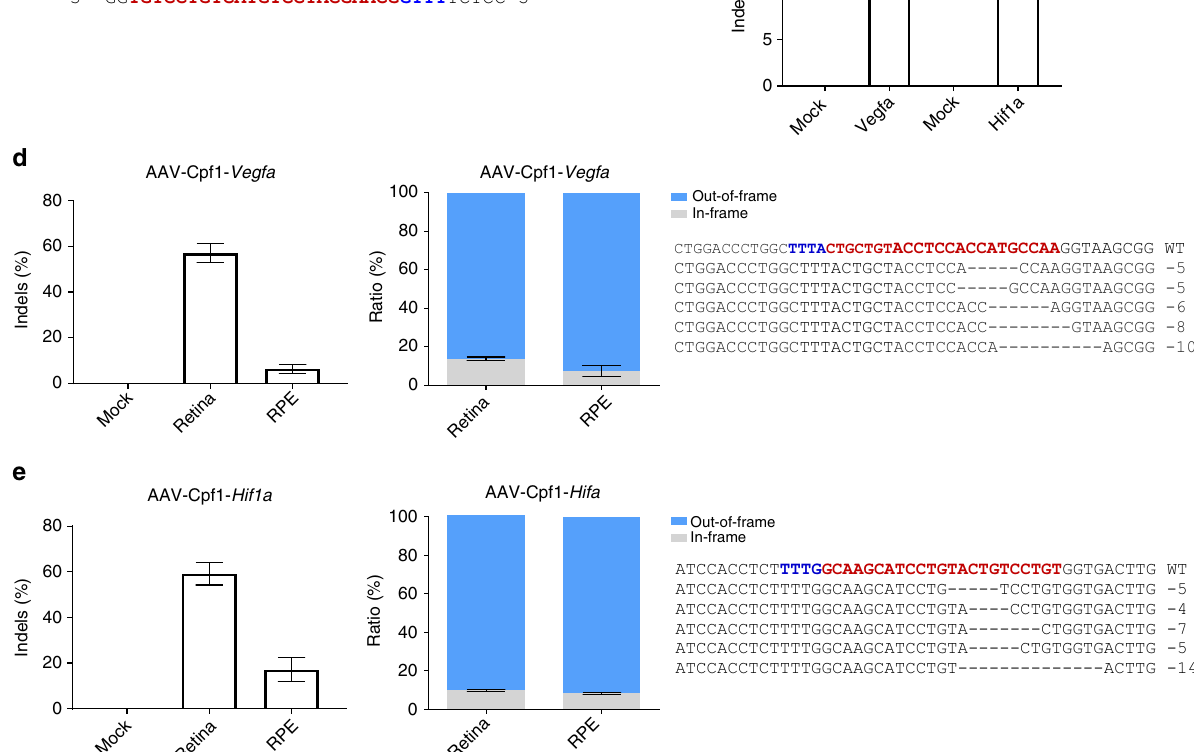
Fig. 1 Genome editing with LbCpf1 in vitro and in vivo. a Mutation frequencies at the Vegfa and Hif1a target sites in C2C12 cells co-transfected with various crRNAs and LbCpf1 genome editing ef fi ciencies were examined by deep sequencing using genome DNA isolated from cells after 48 h of transfection. Error bars indicate s.e.m. ( n = 3). b The Cpf1 target sequences in the Vegfa and Hif1a genes. The PAM sequence and the crRNA target sequence (TS3) are shown in blue and red, respectively. c All-in-one AAV vector plasmids encoding Cpf1 and its crRNA (TS3) and its mutation frequencies at the Vegfa and Hif1a target sites in C2C12 cells transfected with pAAV-Cpf1- Vegfa or Hif1a plasmids 48 h post-transfection. d , e Indel frequencies and mutant sequences presented with two fractions, in-frame versus out-of-frame indels at the Vegfa ( d ) or Hif1a ( e ) target site in the retina and RPE cells using deep sequencing 6 weeks post-intravitreal injection of AAV-Cpf1- Vegfa or AAV-Cpf1- Hif1a . The PAM sequence and the crRNA target sequence (TS3) are shown in blue and red, respectively. Error bars indicate s.e.m. ( n =